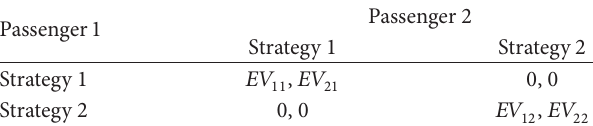
Table 1: Revenue matrix of